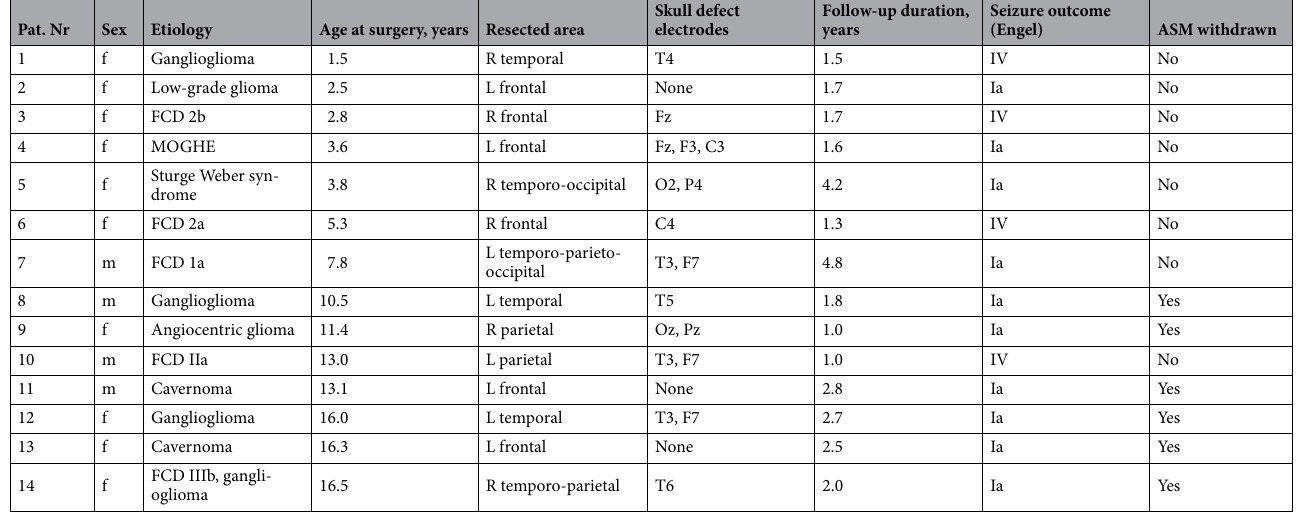
Table 1. Clinical features of our patients. Clinical features include the etiological substrate, as verified by histopathology, the lobar localization and lateralization of the resected area, the skull defect electrodes in postsurgical EEG, the postsurgical seizure outcome, and the ASM status at last follow-up for each patient. Pat. Patient, nr number, m male, f female, FCD focal cortical dysplasia, MOGHE mild malformation of cortical development with oligodendroglial hyperplasia and epilepsy, L left, R right, ASM anti-seizure medication.